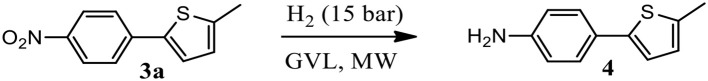
Optimized conditions for the MW-assisted reduction step.